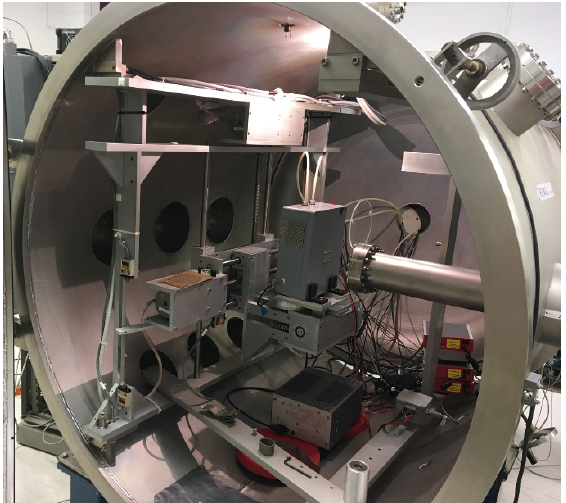
Figure 4. An overview of the experimental setup used for high-flux X-ray measurements at the Livio Scarsi X-ray facility . The CZT pixel detectors (enclosed in the grey rectangular box, together with the preamplifier PIXIE ASIC) were irradiated with Mo target X-rays (the tube on the right side). The red boxes, on the bottom right side, are the digitizers of the digital pulse processing electronics. The detector box was mounted on a micro-translator system, which can be moved in x , y , and z directions with a precision of 10 μ m.